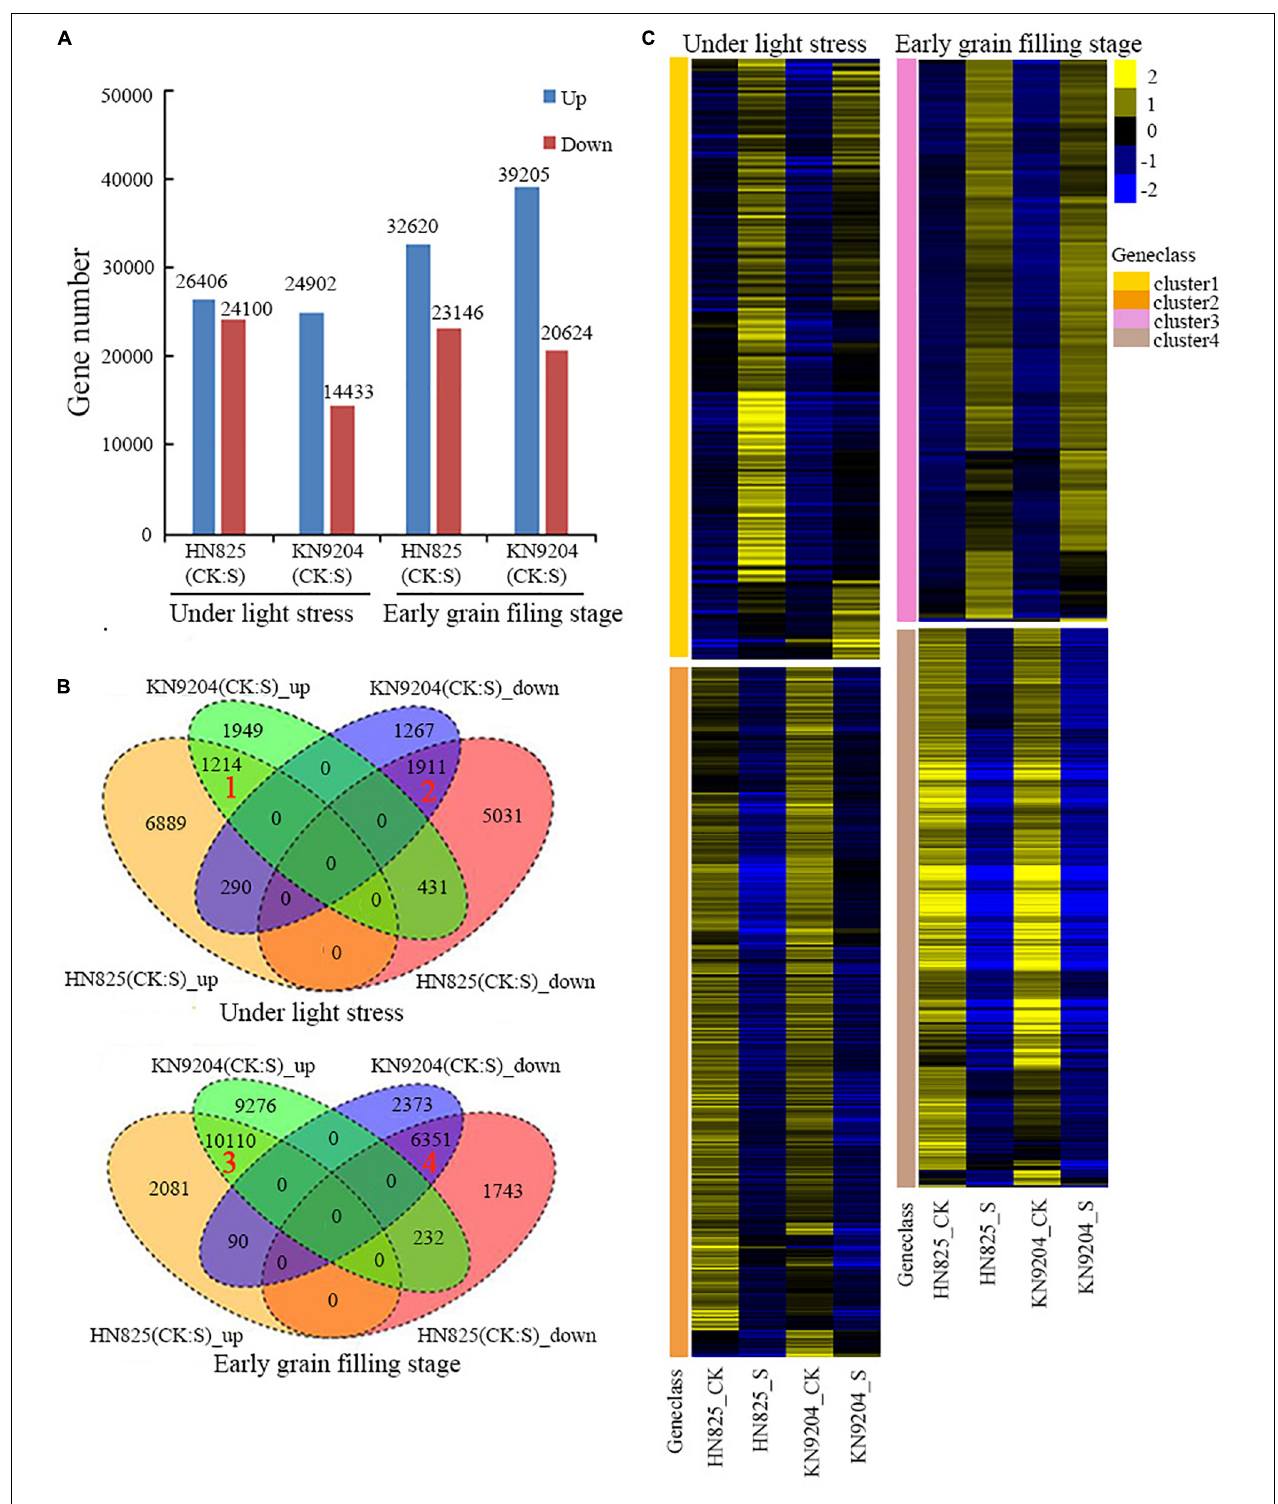
FIGURE 7 | Analysis of RNA-sequencing data of the spike in low light stress (during young microspore) and early grain filling stage (20 days after low light treatment) under low light stress (S) and control (CK) conditions. (A) The numbers of the differentially expressed genes (DEGs). (B) Venn diagram analysis of all up-regulated and down-regulated DEGs in two wheat cultivars (‘HN825’ and ‘KN9204’). (C) Heatmap clustering of the up-regulated (cluster 1 and 3) and down-regulated (cluster 2, 4) in both cultivars under low light stress and early grain filling stage.